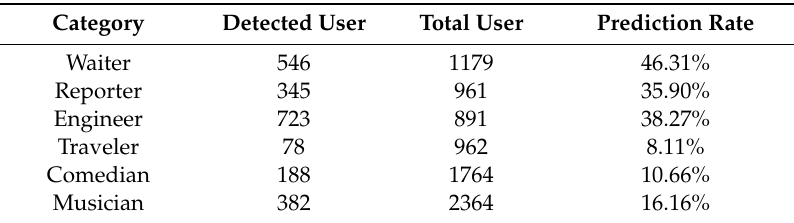
Table 8. Evaluation on the occupation-oriented dataset.